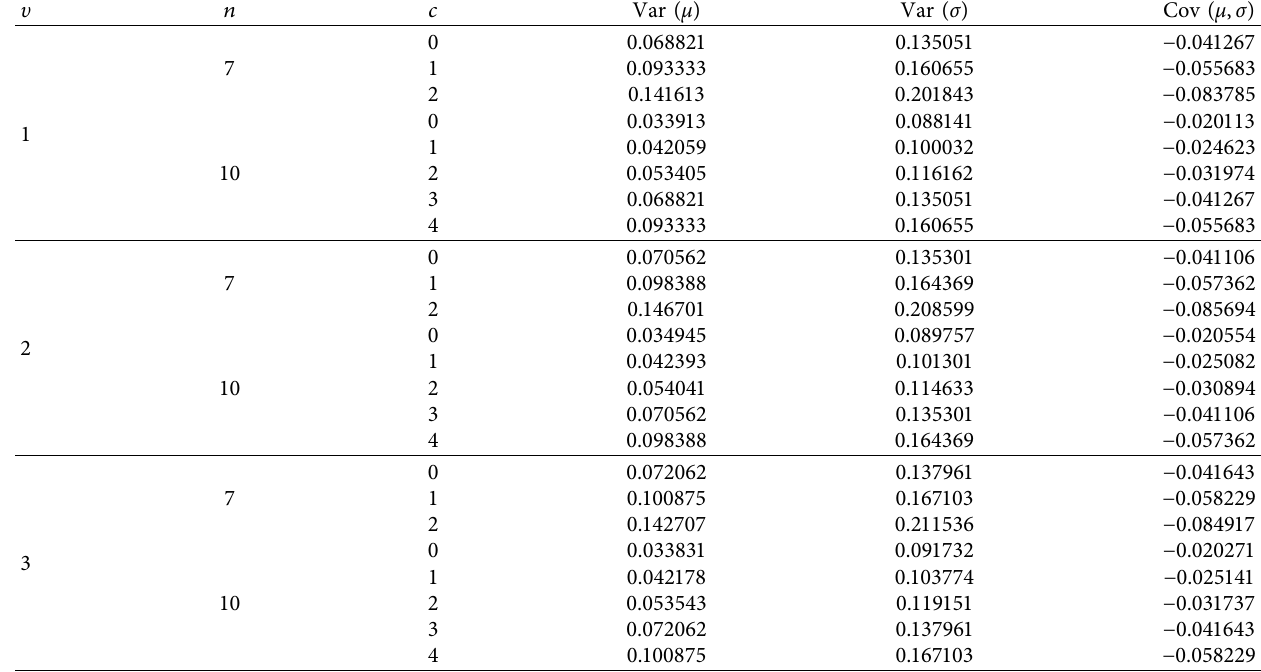
Table 3: Variance and covariance of the BLUEs when μ � 0 and σ �